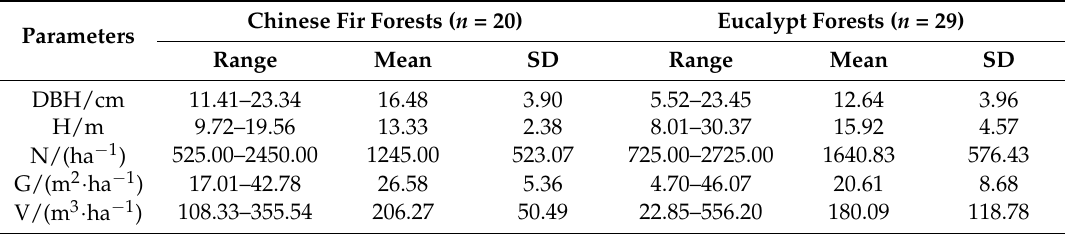
Table 1. Summary of field